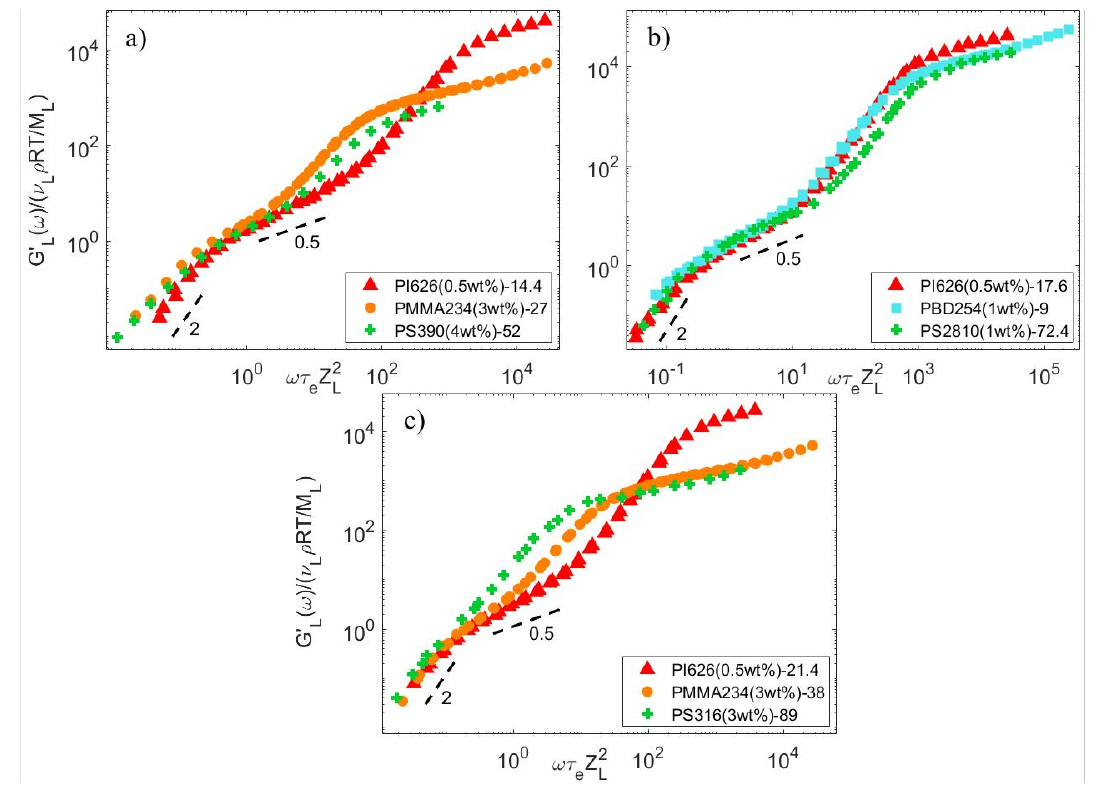
Figure 8. Normalized storage modulus of specific datasets with similar Z_S, such that ( a ) Z_S=4, ( b ) Z_S=5, and ( c )